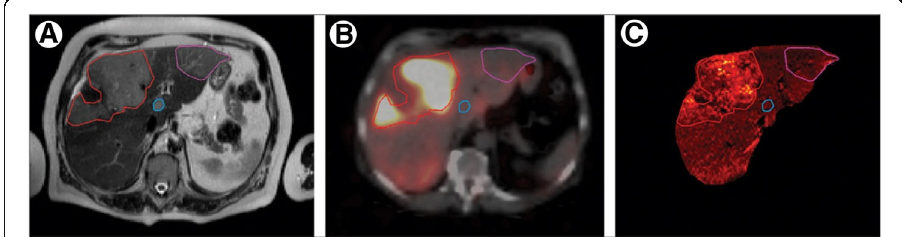
Fig. 4 Intrahepatic visualisation of 166 Ho-microspheres after SIRT. T2-weighted MRI of the liver in a